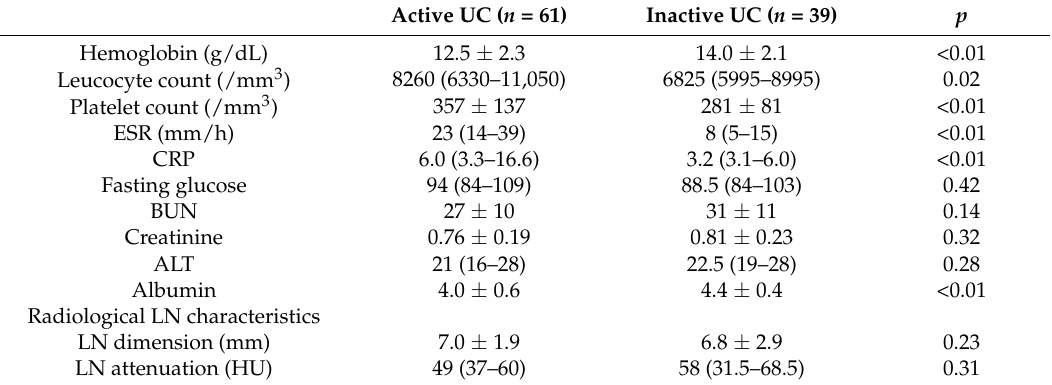
Table 2. Laboratory values and lymph node characteristics of patients with active and inactive